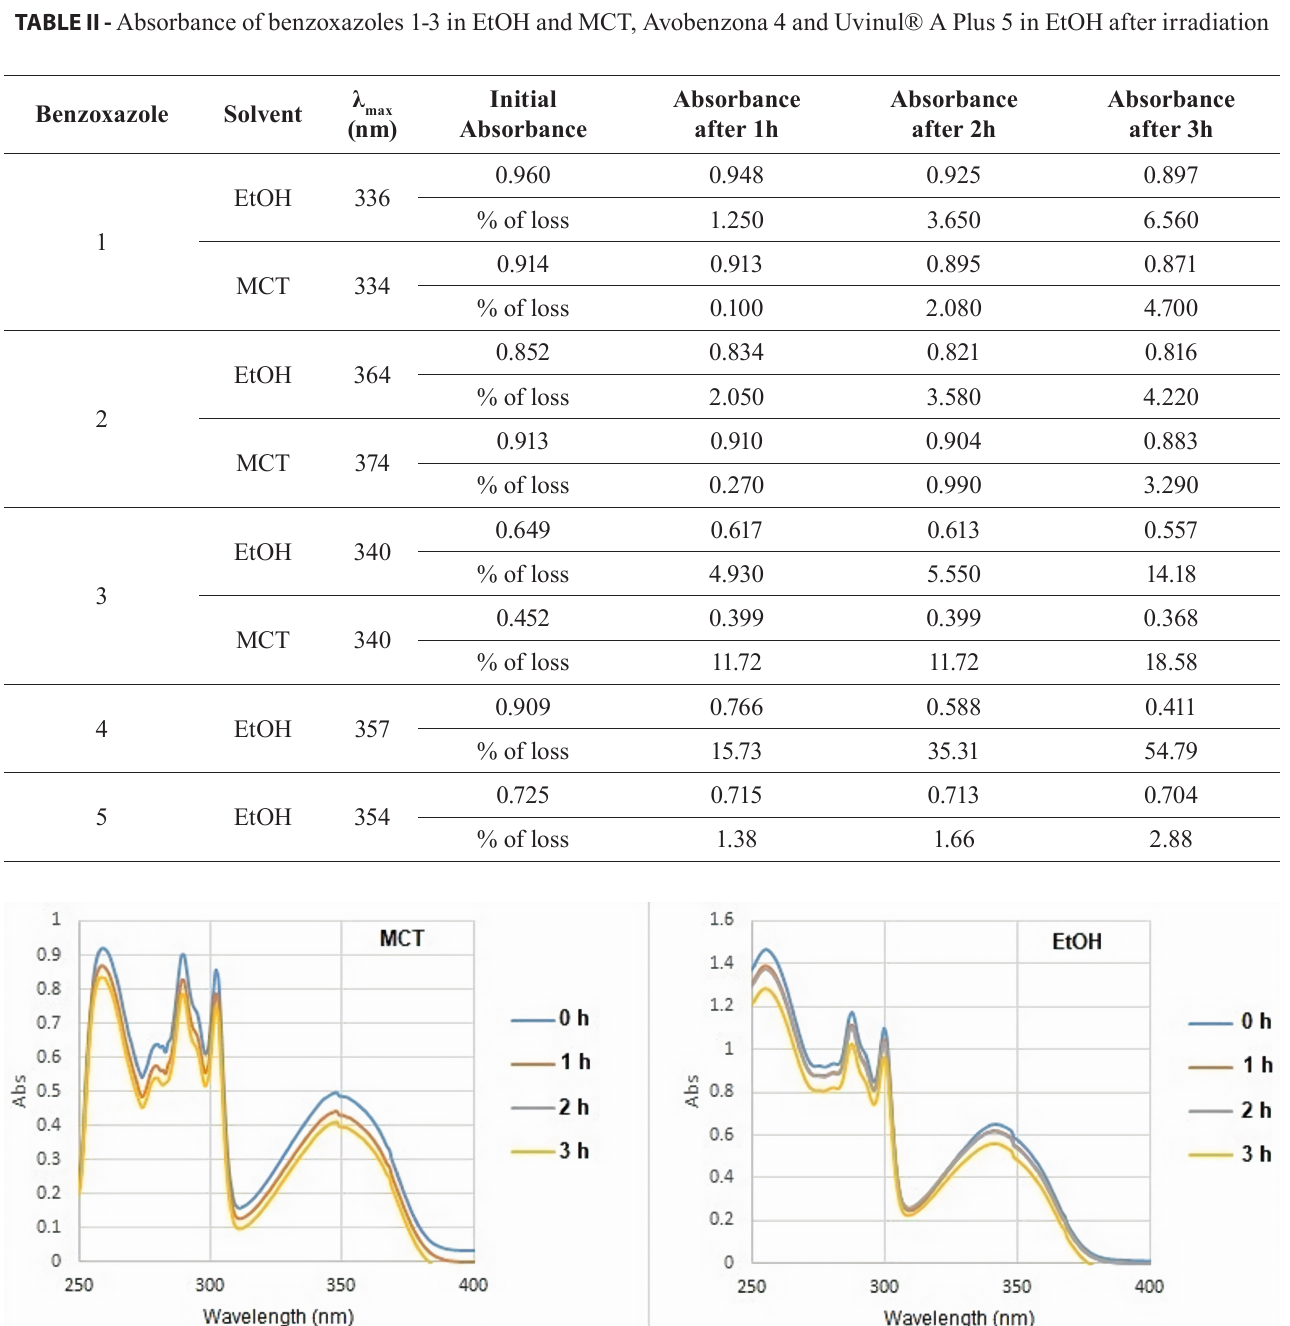
FIGURE 3 - Absorption spectra of benzoxazole dye 3 in MCT and ethanol up to 3 hours of exposition in the solar